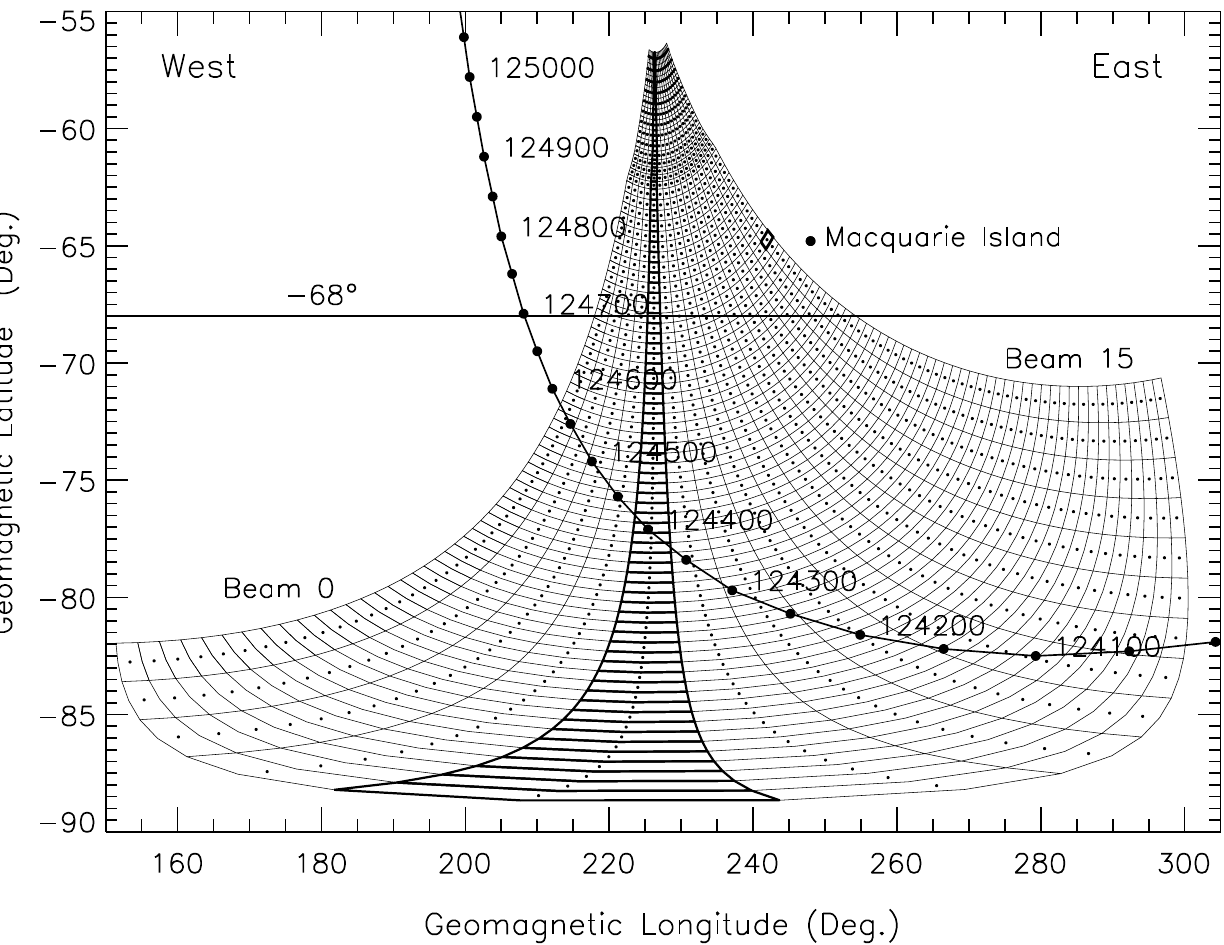
Fig. 2. The track of the DMSP F14 spacecraft through the TIGER field-of-view during 12:40:00 to 12:51:00UT, 10 December 1999. The satellite track and the 75 range cells sampled on each of the 16 beams of TIGER have been plotted on the same grid of magnetic latitude and longitude. Beam 0 is the western-most beam (left) and beam 15 is the eastern-most beam (right). Beam 4, drawn in bold, points along the 226 ◦ E magnetic meridian, but diverges towards the west at higher latitude. Range cell 26 of beam 15 is also drawn in bold because it is the closest observation cell to MQI on the same